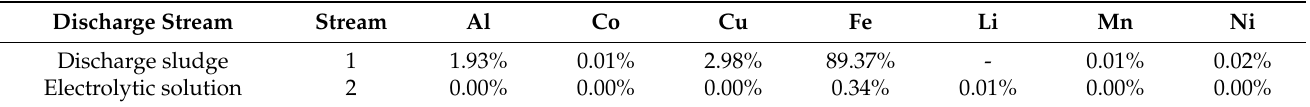
Figure 2. Field Emission Scanning Electron Microscope with Energy Dispersive Spectroscopy (FESEM-EDS) layered map for discharge residue. Table 1. Percentage of metals in the feed reporting to the LIB discharging side streams.